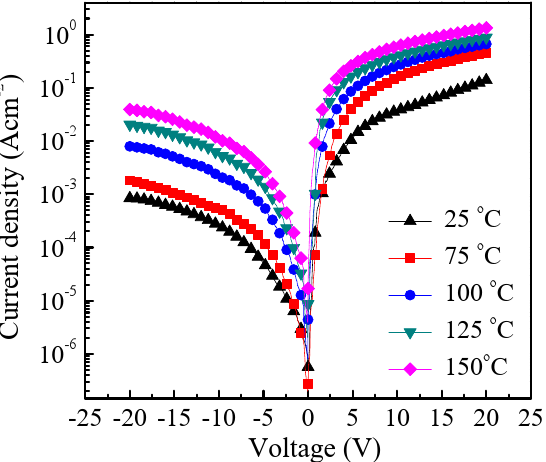
Figure 7. The reverse and forward current density–voltage (I–V) plots of the p-Sb 0.14 GaN/ n -Si heterojunction diodes measured at the different temperatures, ranging from 25 °C to 150 °C.